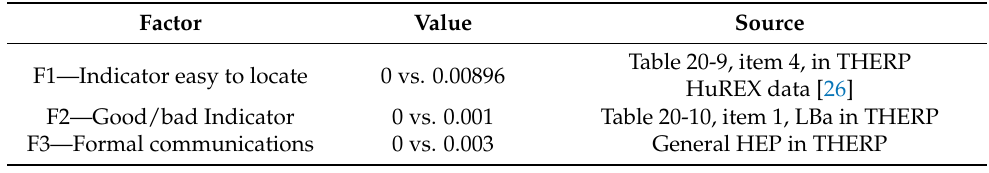
Table 7. Branch HEPs for Pcc used in the MCBDT method.